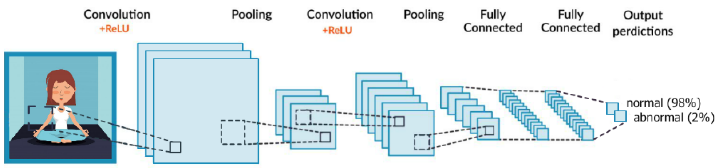
Figure 13. Convolutional neural network for meditation pose estimation.